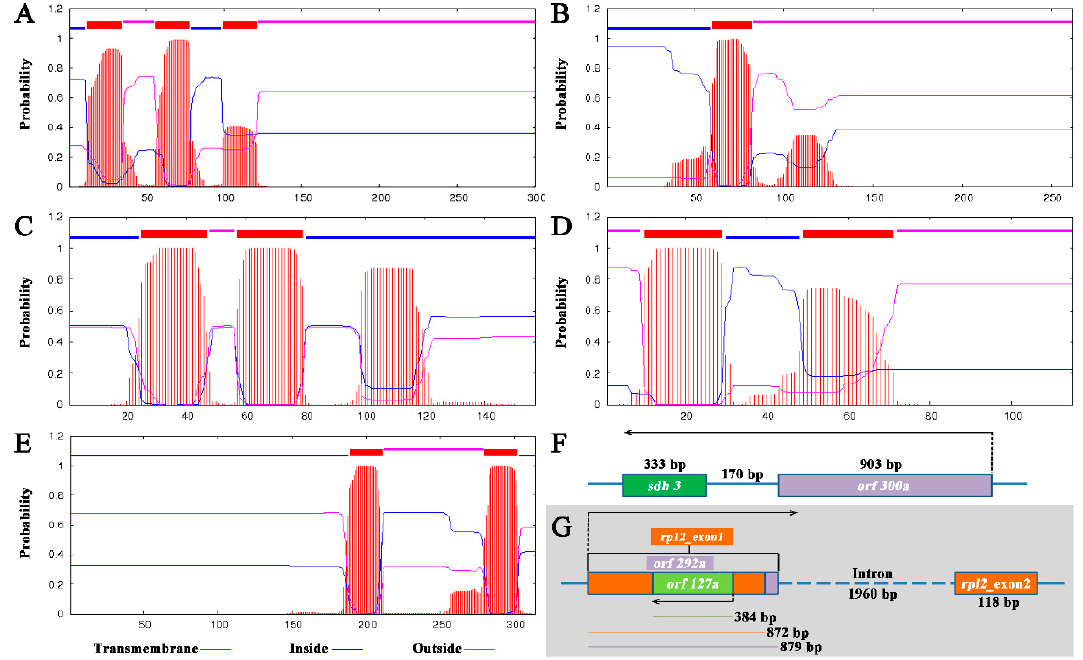
Figure 4. Chimeric structures, co-transcribe event, and transmembrane domain of the specific ORFs in 138A. ( A – E ): Locations and probabilities of the transmembrane domains of the gene products of orf300a ( A ); orf262a ( B ); orf157a ( C ); orf115b ( D ); and orf314a ( E ). ( F ) Co-transcribe structure of orf300a and sdh3 ; ( G ) chimeric structure of orf292a and rpl2 - exon1, a long horizontal arrow shows orientation of transcription.